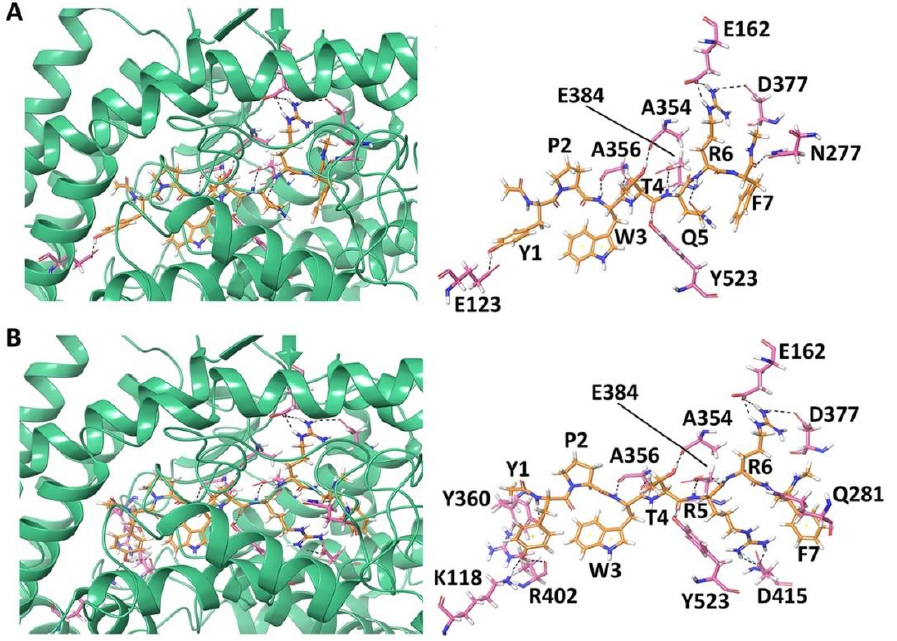
Figure 2. Docked pose and hydrogen bond interactions between hemorphin-7 and angiotensin-I converting enzyme (ACE) ( A ) YPWTQRF; and, ( B ) YPWTRRF. The ACE protein is shown in green cartoon representation and its interacting residues are shown in pink stick representation; the docked ligand is represented as orange sticks, and hydrogen bonds are shown as black dashed lines.